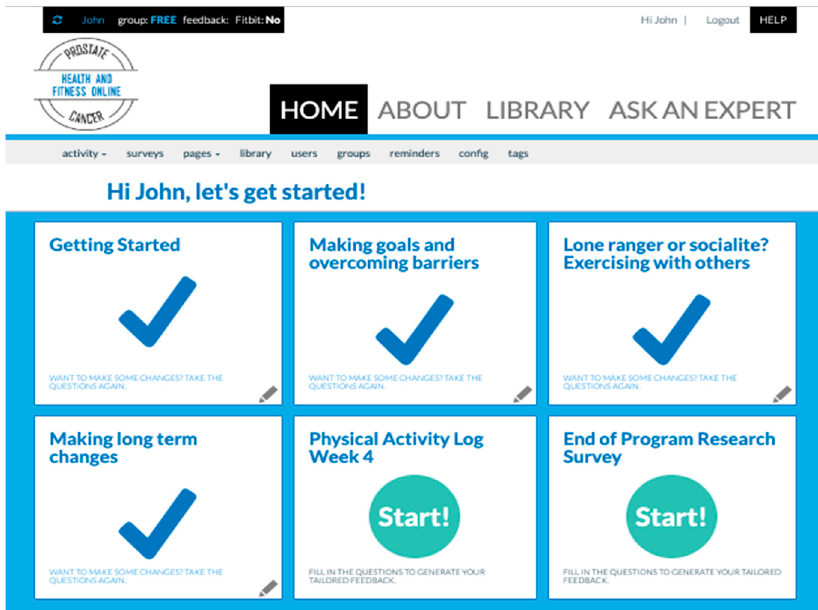
Figure 3. Free-choice website homepage (administrator view). This condition was designed to be autonomy supportive. Users could click on any topic at any time. Physical activity self-monitoring and feedback were supported by clicking on the physical activity log module. This automatically updated according to what week of the program the user was up to.